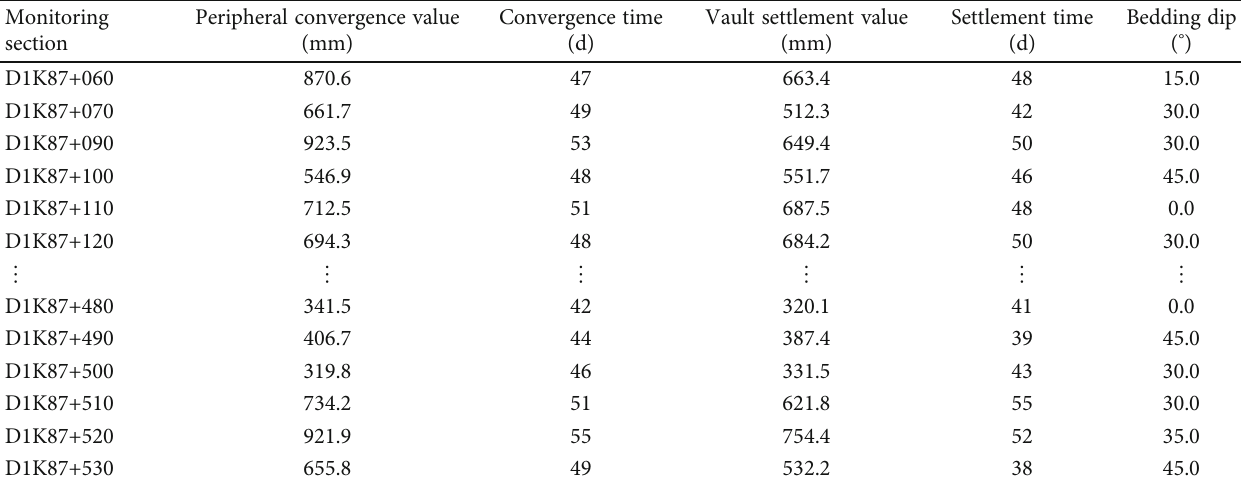
Table 1: Tunnel site monitoring and measurement data.